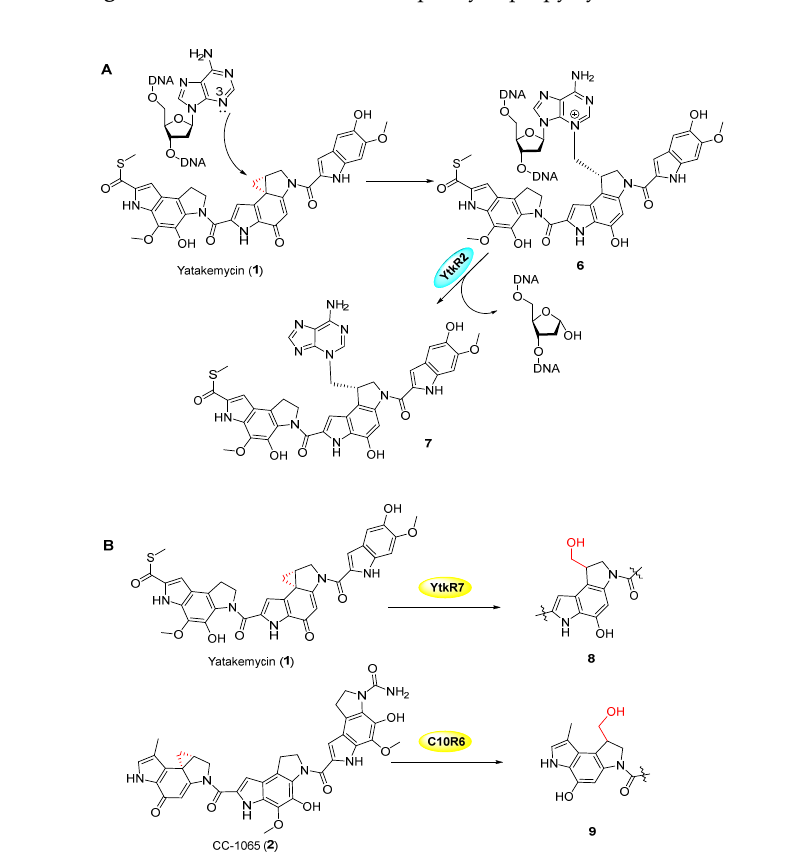
Figure 1. Chemical structures of spirocyclopropylcyclohexadienone family compounds.